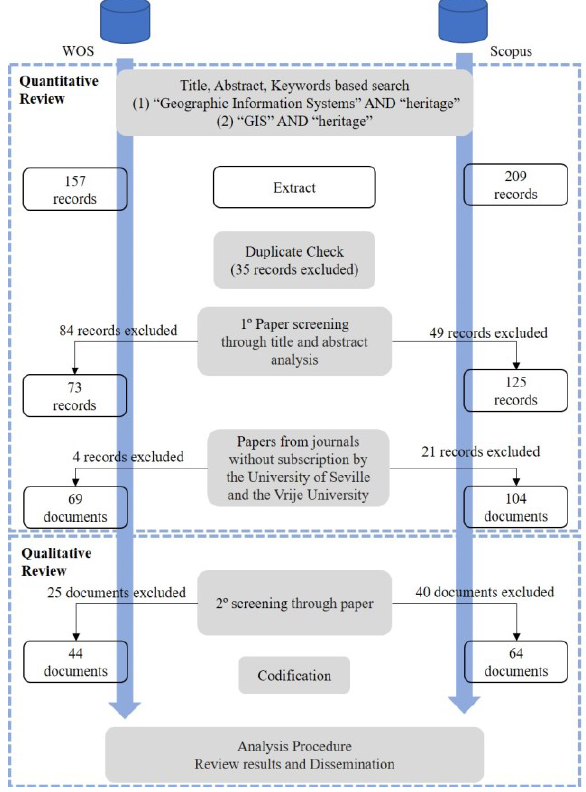
Figure 1: Flow diagram of the SLR methodology, number of publications included and excluded in each